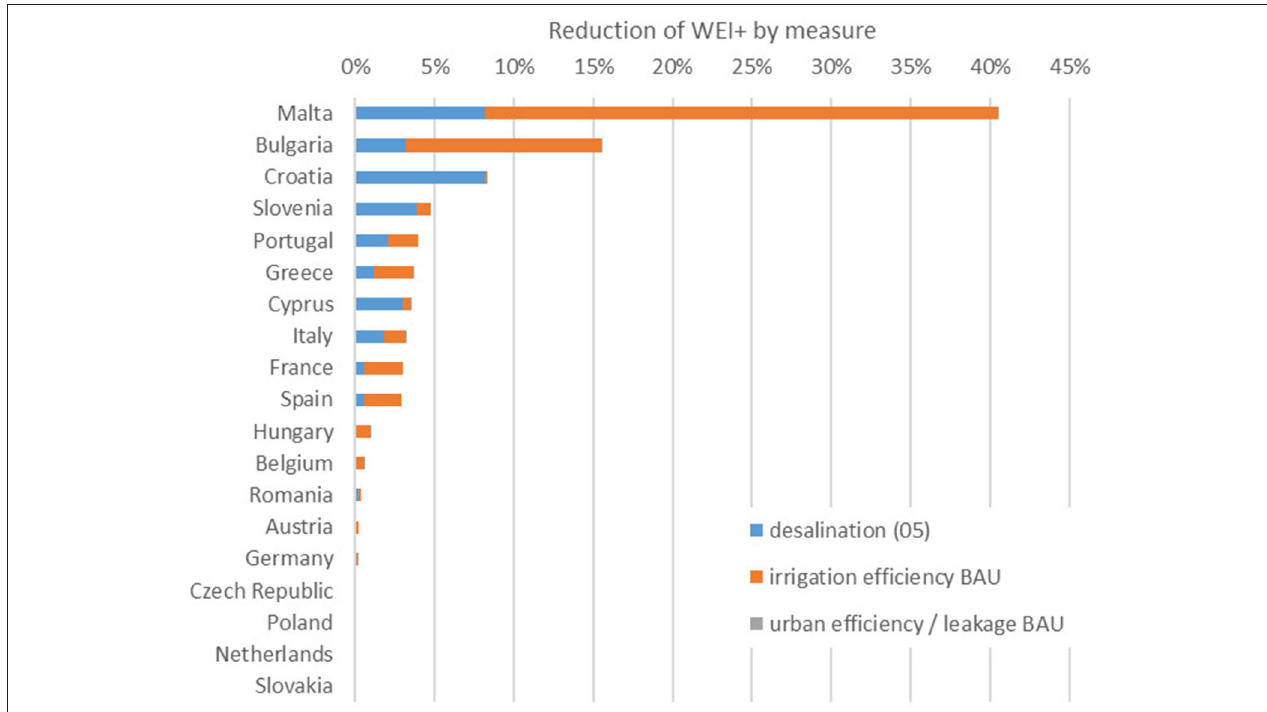
FIGURE 9 | Effects of three water efficiency measures on WEI + (consumption) as estimated with the LISFLOOD model. Note: water reuse does not influence WEI + as it is used by irrigation.